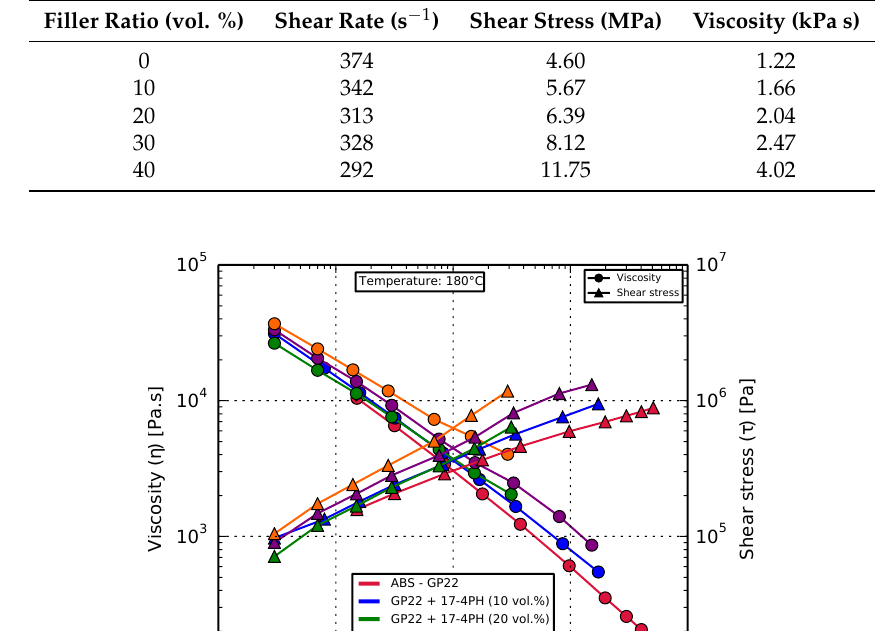
Table 2. Rheological behavior of pure ABS and composite feedstocks. Filler Ratio (vol. %)